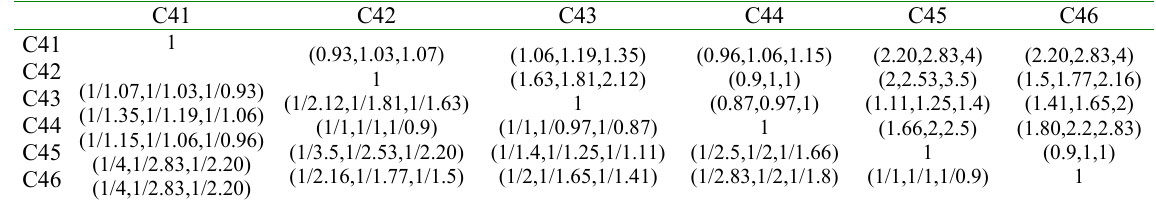
Table 21. Fuzzy aggregated evaluation matrix C4